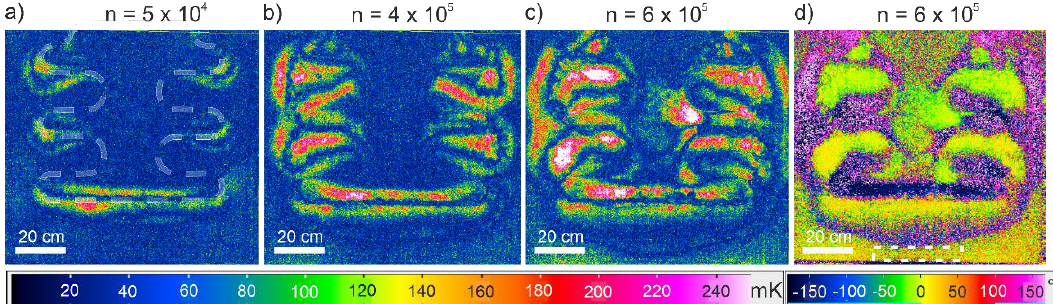
Figure 4. Lock-In amplitude images of sample ‘B24’ at ( a ) 5 × 10 4 , ( b ) 4 × 10 5 and ( c ) 6 × 10 5 loading cycles and ( d ) corresponding lock-in phase image with a dotted line indicating the reference area for the calculation model, ( a ) white dotted lines show the insert